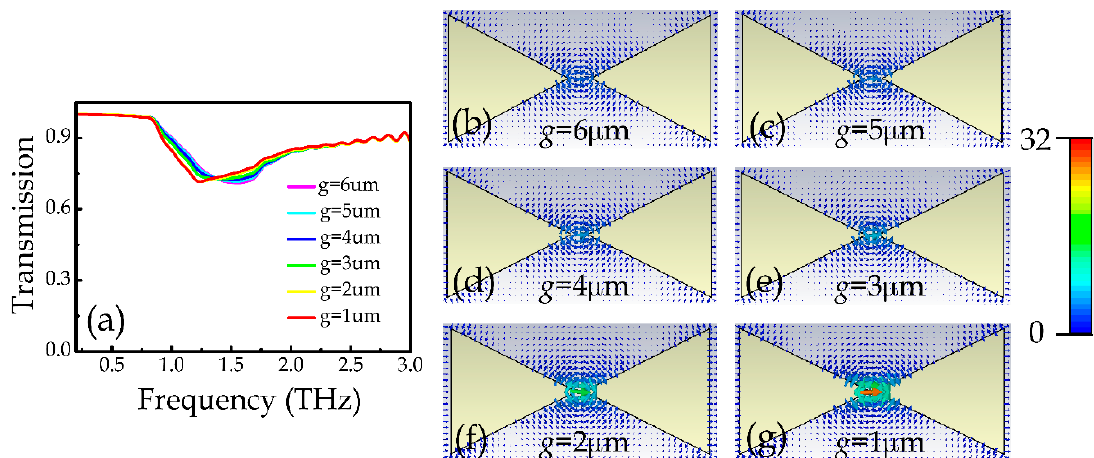
Figure 3. ( a ) Simulated transmission spectra of the DTD structures with different g from 6 to 1 μ m under x-polarized incidences, respectively. ( b – g ) Simulated electric field distributions of the DTD structures with different g from 6 to 1 μ m at the corresponding BDP resonance frequencies under x -polarized incidences, respectively.